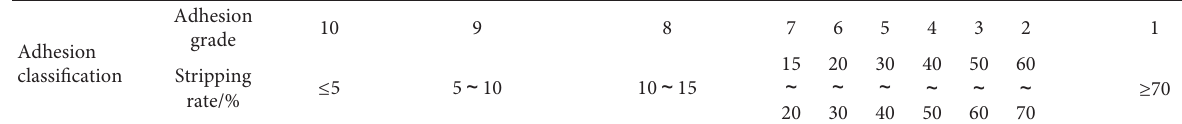
Figure 7: 3D contour surface of the aggregate: (a) analysis area; (b) contour surface point Table 4: 10-level grading standard for asphalt adhesion.